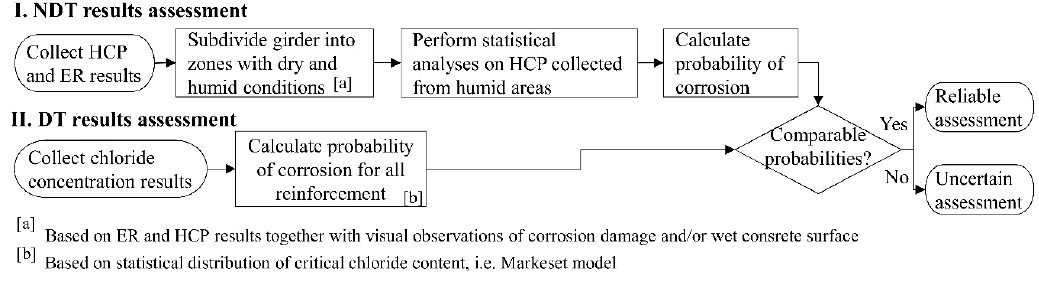
Figure 20. Procedure for assessment of pretensioned bridge girders in a marine environment.